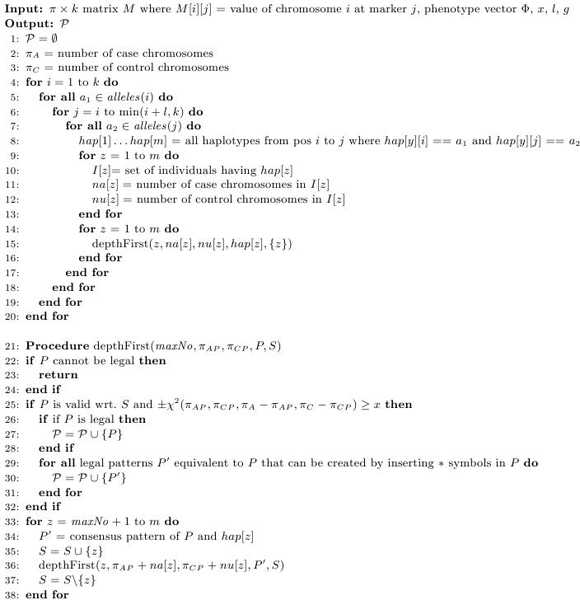
New HPM algorithm. Pseudocode for the new HPM algorithm.